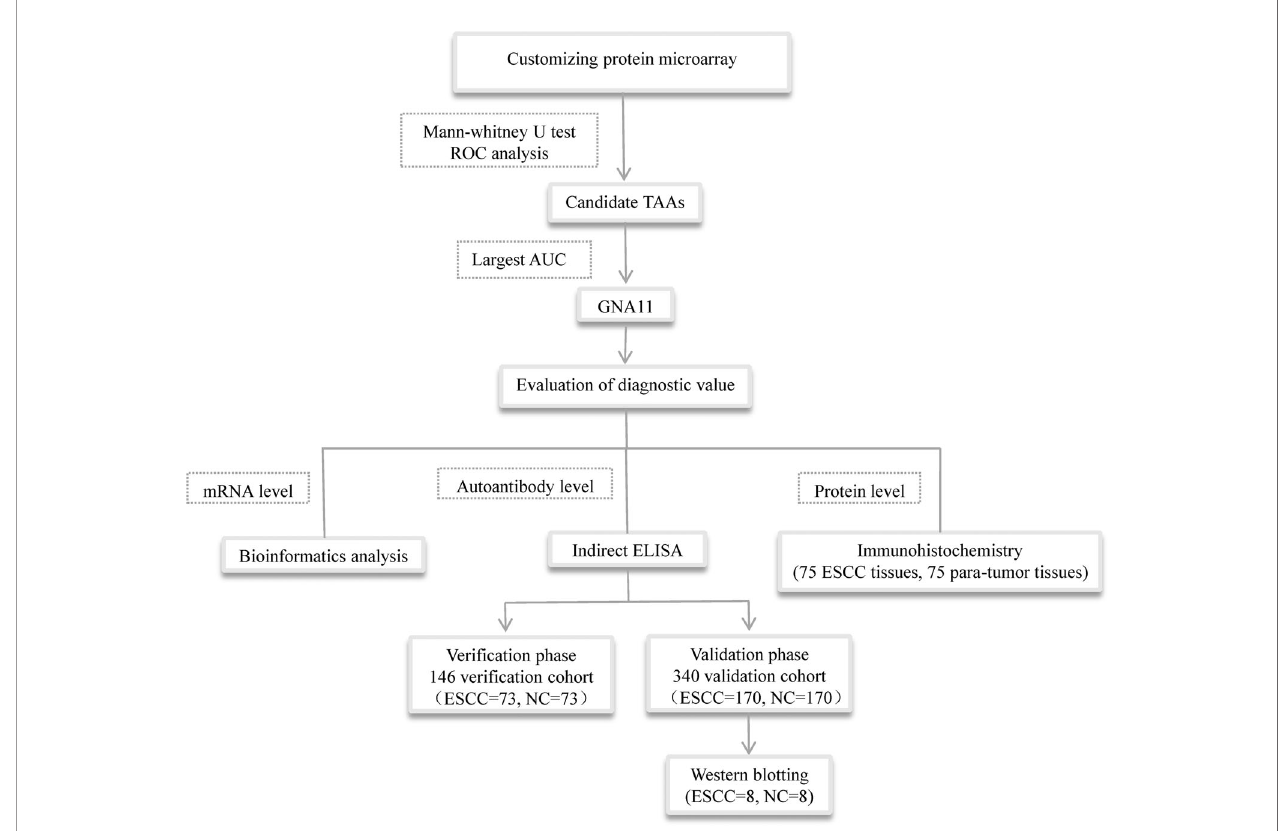
FIGURE 1 | The overall design of the study. TAAs, tumor-associated antigens; ELISA, enzyme-linked immunosorbent